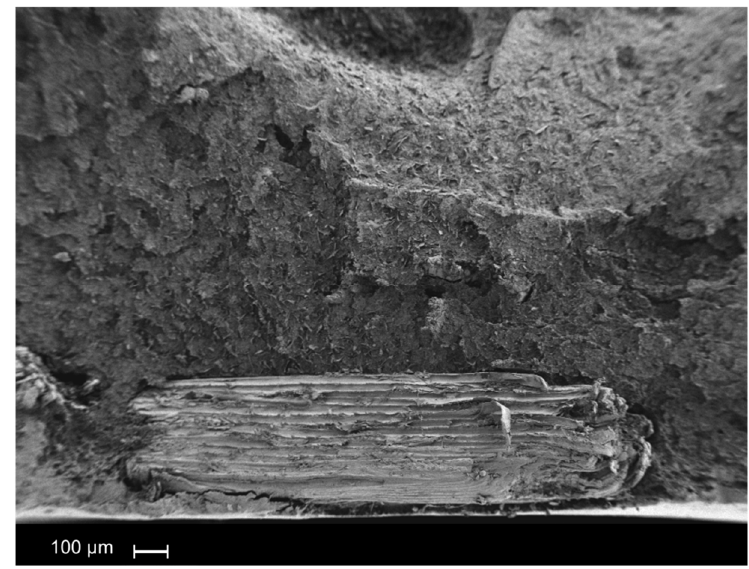
Figure 12. SEM micrographs of largest sized particles—10 wt.% of wood flour ×50.